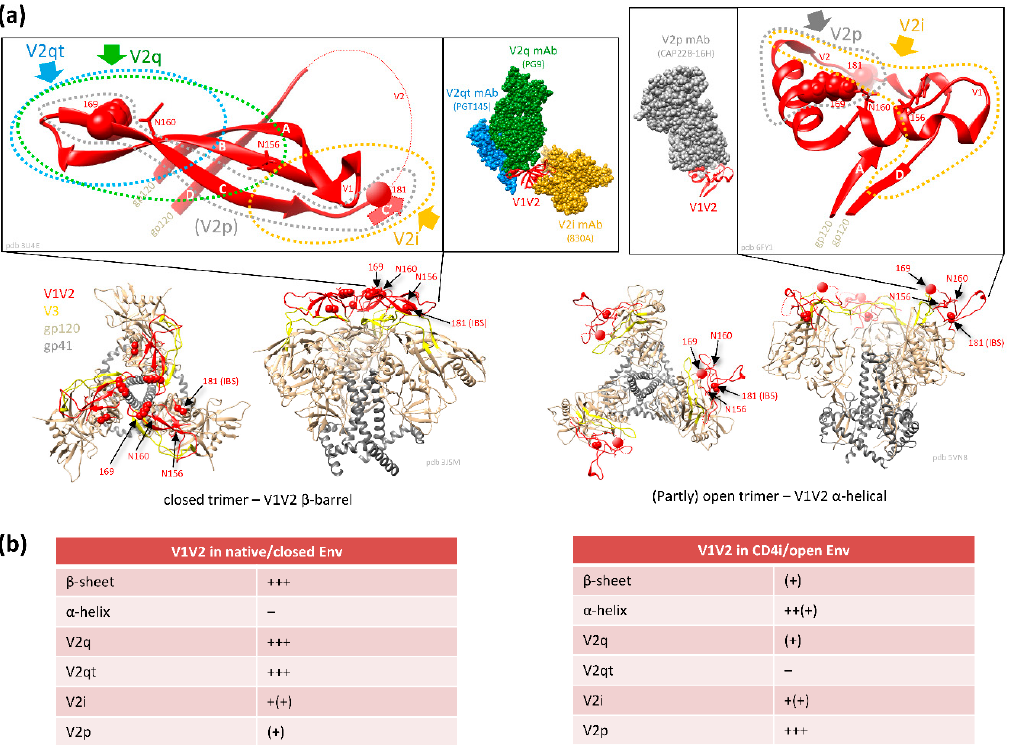
Figure 1. Conformational plasticity of the variable V1V2 region and structural requirements for the binding of di ff erent V1V2-specific Abs. ( a ) Trimeric architecture of HIV-1 Env in a closed (pdb 3J5M, Env derived from a PGV04 Fab-stabilized SOSIP co-structure [46]) and an open conformation (pdb 5VN8, Env derived from a b12 Fab-stabilized SOSIP co-structure [52]). Env regions are colored as indicated in the legend; e.g., V1V2 regions are shown in red and V3 regions in yellow. Key V1V2 residues are labeled in one protomer: conserved N-glycosylation sites N156 and N160 are shown in stick representation and sites of immune pressure in RV144 as spheres, i.e., aa 169 and aa 181, the latter being part of the integrin binding site (IBS). Boxed: magnification of V1V2 regions with encircled antigenic V1V2 regions, shown for “closed Env” in preferential β -sheet conformation (left, pdb 3U4E, V1V2 derived from a PG9-stabilized co-structure [53]) and for “open Env” in preferential α -helical conformation (right, pdb 6FY1, V1V2 derived from a CAP228-16H-stabilized co-structure [22]). V1 and V2 loops, gp120 stumps, and the β -sheets A-D are indicated. The binding pattern of di ff erent V2 Ab classes is schematically shown with colored ovals and arrows. mAb-bound V1V2 co-structures are displayed in additional boxes. For the V1V2 β -barrel conformation (left) an overlay was generated for PGT145 mAb-bound V1V2 (pdb 5V8L [54]), PG9 mAb-bound V1V2 (pdb 3U4E), and 830 mAb-bound V1V2 (pdb 4YWG [47]) using Matchmaker in Chimera v.1.13.1 (matching restricted to V1V2 regions). Schematics of key regions were manually added if structurally not resolved, i.e., β -strand C’ (arrow), some V1 and V2 loops (red dashed lines), and some aa 169 and 181 residues (spheres). ( b ) Secondary structural content of V1V2 and preferential binding patterns of the di ff erent V2 Ab classes to the native / closed versus open Env conformations. Epitope accessibility / binding strength of respective Ab classes is scaled as follows: − absent, + weak, ++ strong, +++ very strong. Parentheses indicate variation within a class. V2 Ab epitopes: V2q: quaternary, V2qt: quaternary and